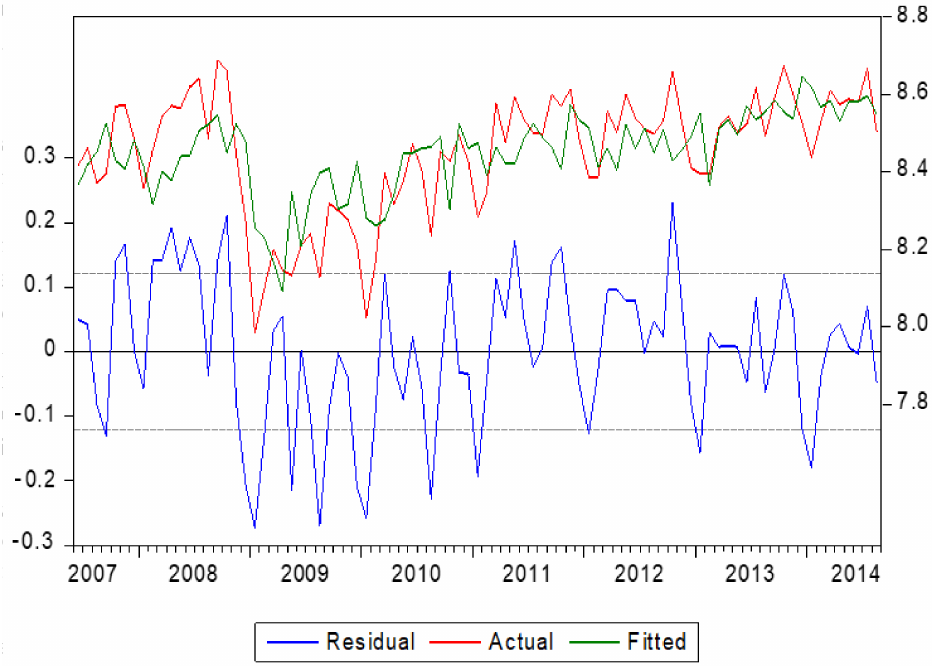
Figure 3. Actual, fitted and residuals of imports’